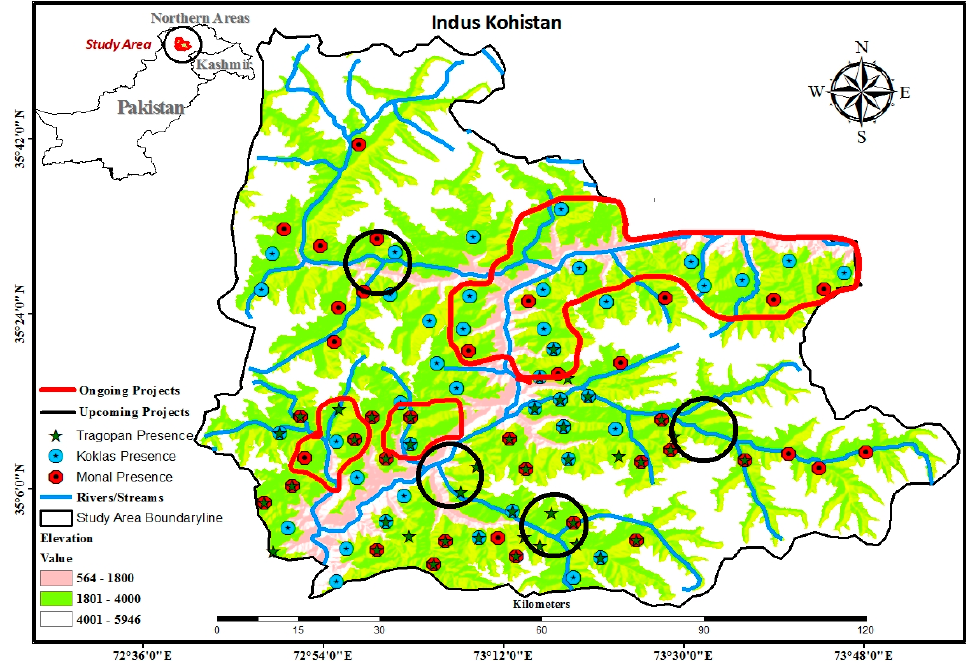
Figure 4. Major infrastructure development projects/Dams and electric power generation projects in the study area show the occurrence points and overlapping of suitable predicted habitats of the pheasant species.